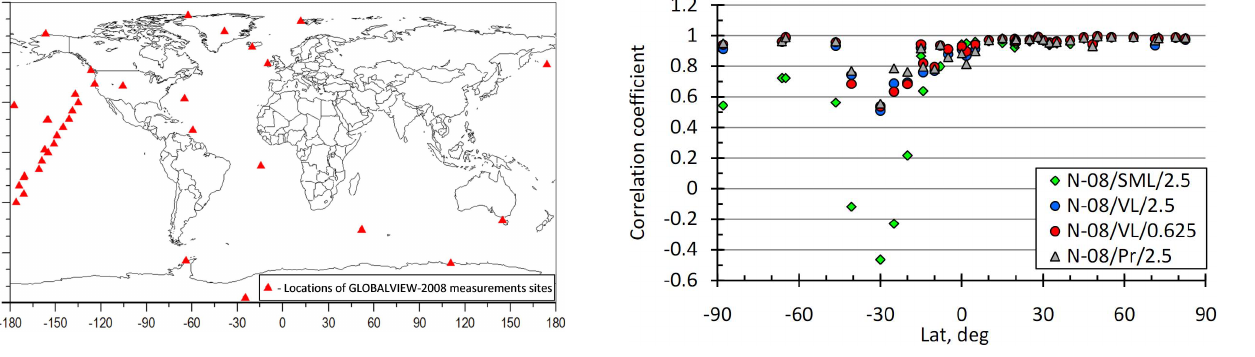
Fig. 5. Locations of GLOBALVIEW-2008 measurement sites. Ob- served data from those sites were used in comparing with simulated results.